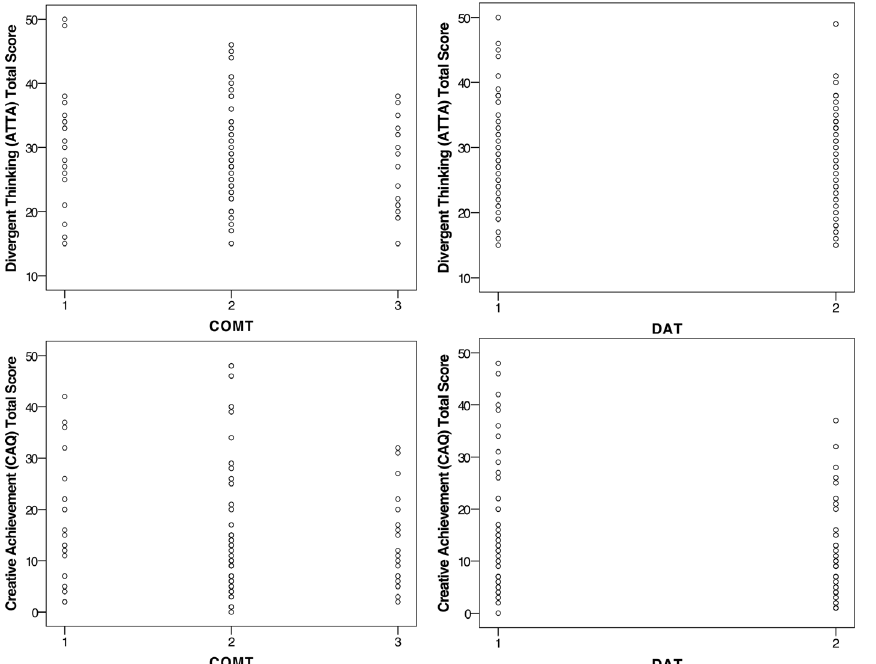
Fig 2. Scatterplots of ATTA and CAQ scores by COMT and DAT